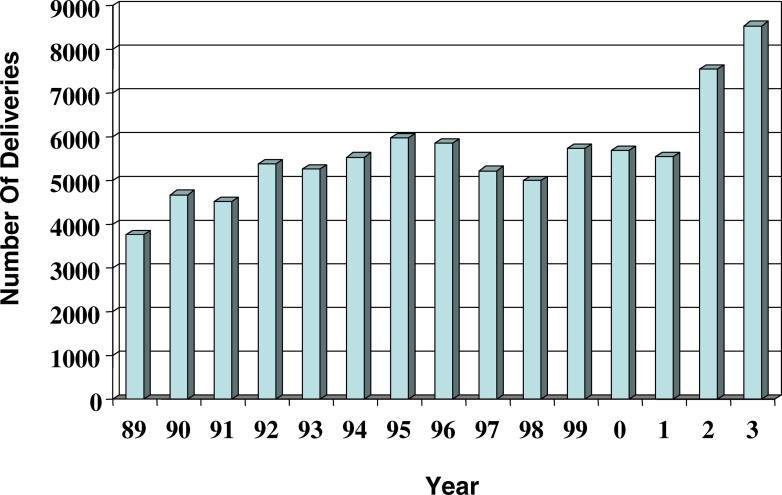
The Rising Number of Deliveries at HAMA